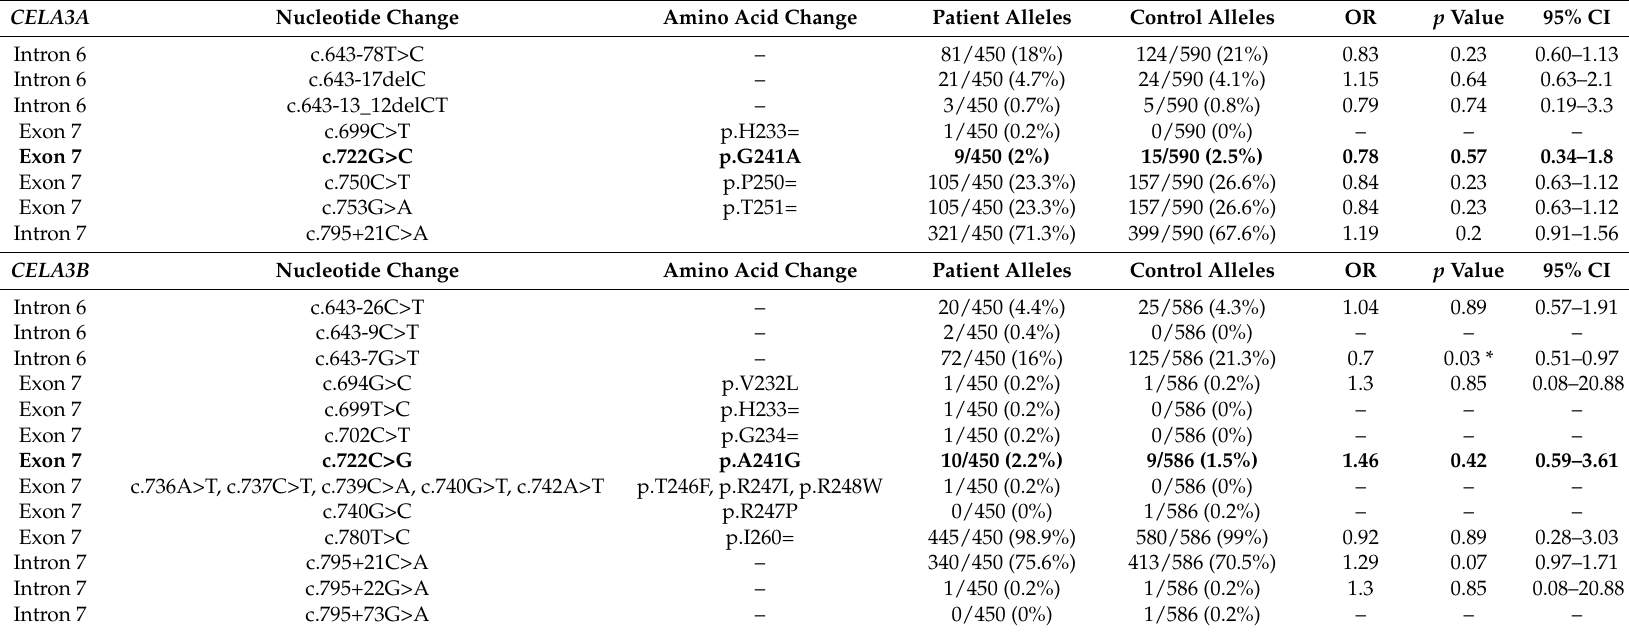
Table 1. Allele frequency of CELA3A and CELA3B variants in patients with chronic pancreatitis and controls without pancreatic disease. Variants affecting position 241 are highlighted in bold. OR, odds ratio; CI, confidence interval. Asterisk indicates significant